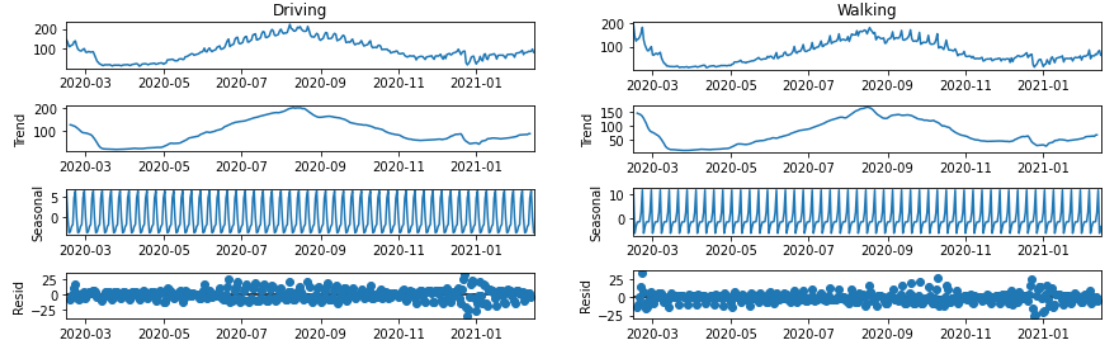
Figure 1. Seasonal decomposition of driving and walking percentage changes in Italy during COVID-19